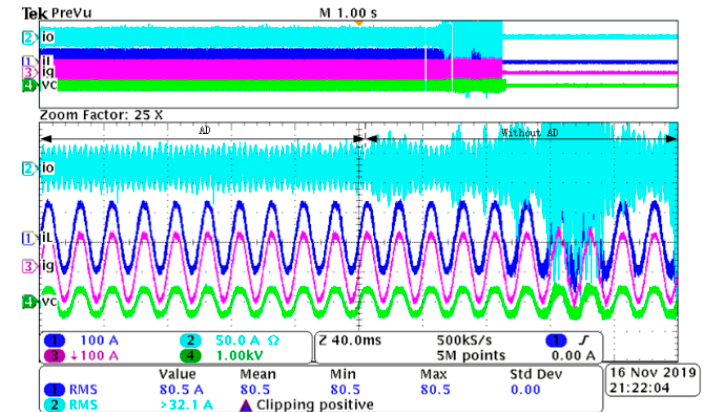
L , i g , and v c between AD and without AD under 60A i L. Energies 2020 , 13 , x FOR PEER REVIEW